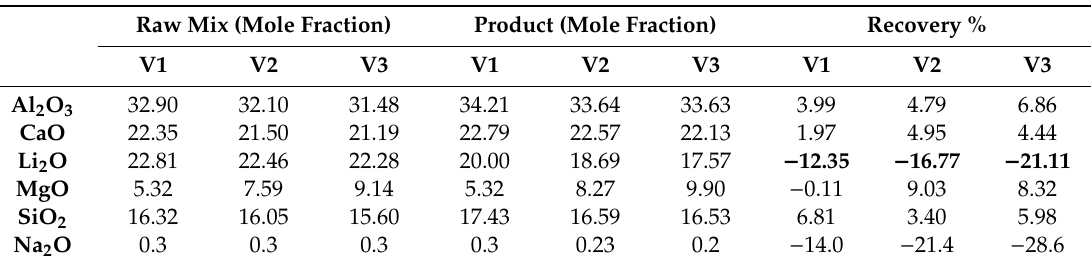
Table 3. Comparison of the Bulk Chemical Composition Measured with ICP-OES of the Four Melt Experiments, Given in Mole Percent. The bold emphazises the Li-loss which is important to see (Li is volatile). Raw Mix (Mole Fraction) Product (Mole Fraction) Recovery %